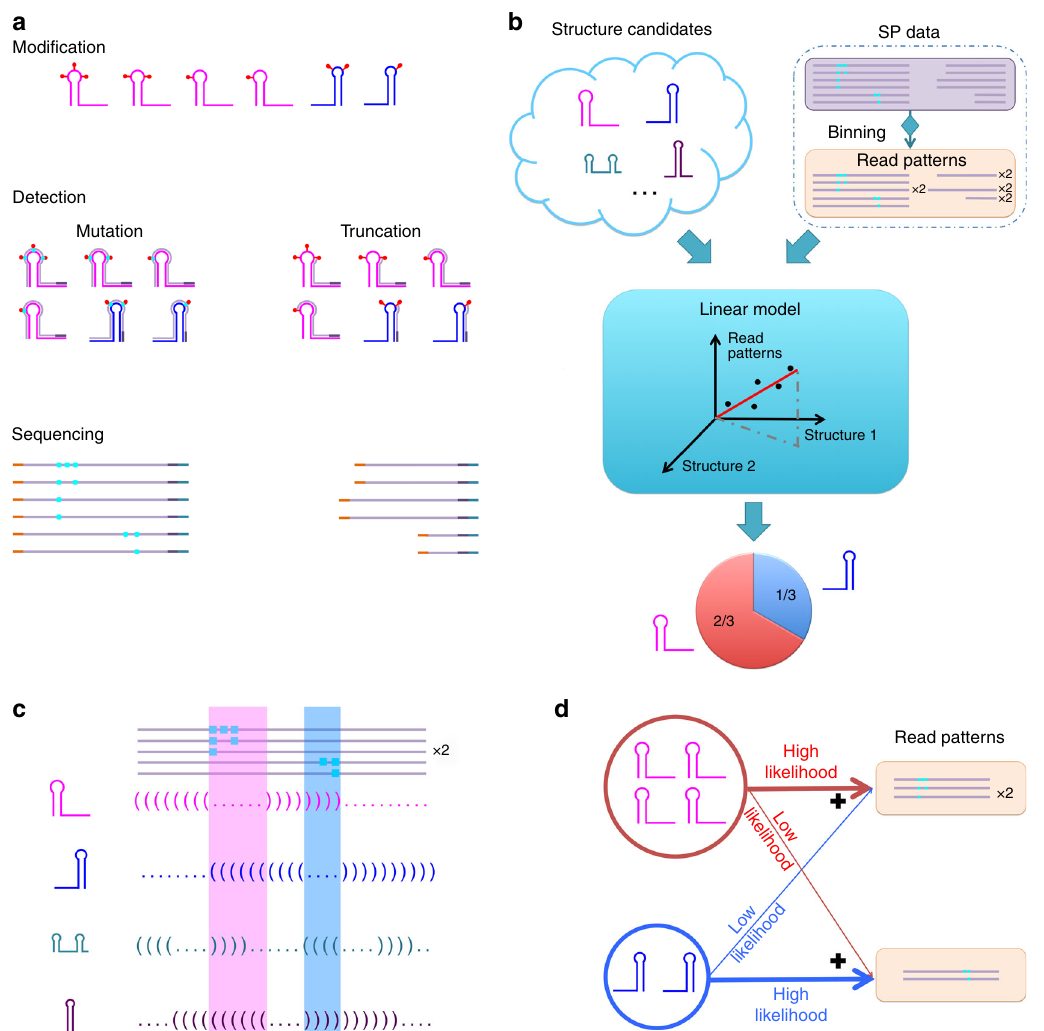
Fig. 1 Cartoon depictions of structure pro fi ling experiments, SLEQ ’ s work fl ow, and its modeling principles. a RNA molecules adopt multiple co-existing structures of potentially differing abundances (magenta and blue hairpins). Structures are probed with a reagent that preferentially modi fi es structurally unconstrained nucleotides. Modi fi cations (red pins) are detected by reverse transcriptase, which either stops or introduces mutations at modi fi ed sites. Complementary DNA products are sequenced and reads are classi fi ed by modi fi cation locations, from which degrees of modi fi cation are quanti fi ed. b Work fl ow of SLEQ. Sequencing reads and candidate structures are input to SLEQ. Reads report detections via truncation or mutation (purple box) and are subsequently binned into patterns (yellow box). See Supplementary Fig. 1 for detailed binning routine. At the core of SLEQ is a linear model that links input structures to observed patterns. Through linear parameter estimation, a small set of structures is selected and their abundances are estimated. c SLEQ selects structures that jointly support observed read patterns. Candidate structures, shown in dot-bracket format, are aligned to read patterns. Modi fi cations occur predominantly in unconstrained nucleotides (dots). Top three patterns are supported by the magenta structure, whereas the bottom two are consistent with the blue structure (background colors highlight loop locations). Green and purple structures are unlikely to generate shown patterns. These principles drive SLEQ to select magenta and blue structures. d Conceptual model description. Each observed pattern may be generated by any underlying structure with a structure-dependent likelihood. The structure-to-pattern likelihood is determined by the degree of consistency between modi fi cations in a pattern and regions of unconstrained nucleotides in the structure. As indicated in c , the magenta structure is highly likely to generate patterns in upper yellow box but unlikely to generate patterns in lower yellow box, and vice versa for the blue structure. Subpopulations of candidate structures then additively contribute to observed pattern counts. Individual subpopulation contributions are determined by their relative abundance